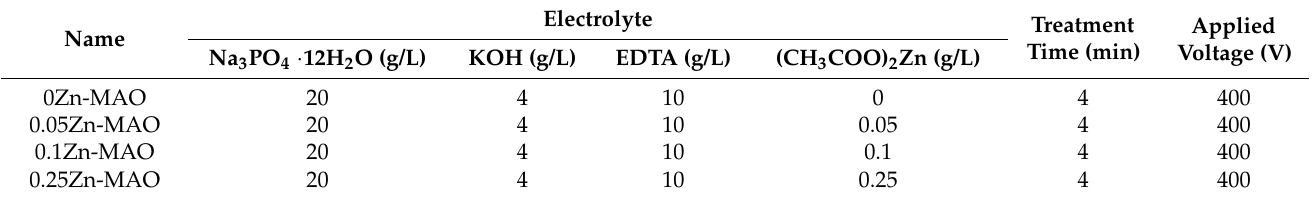
Table 1. Scheme for preparation